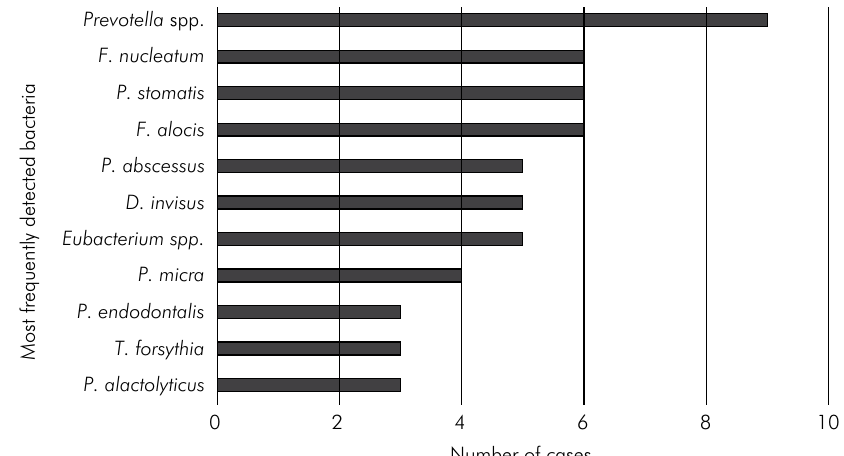
Figure 2. Number of cases presenting the most frequently identified bacteria